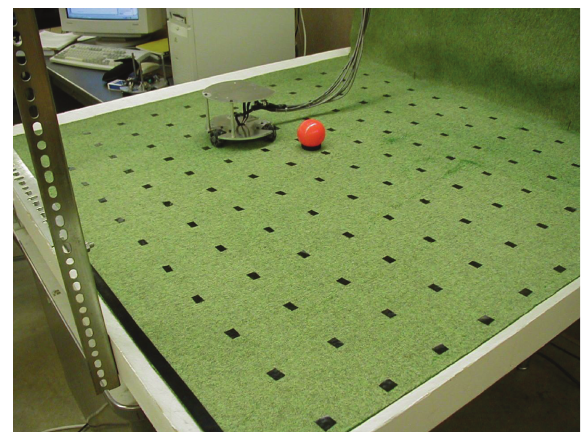
Figure 13: Experimental setup with omnidirectional robot and